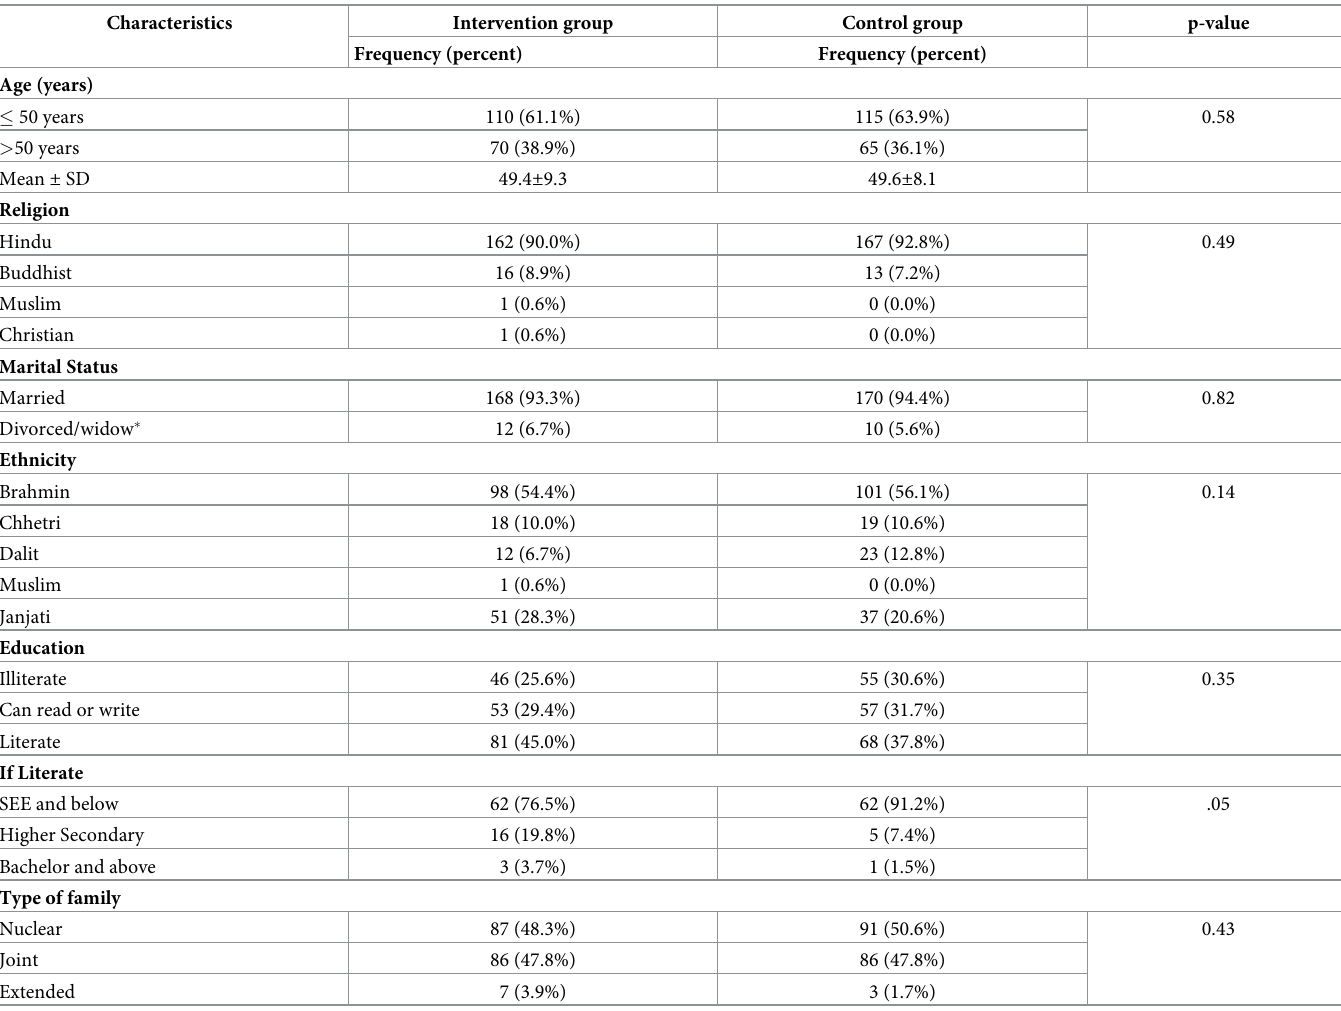
Table 2. Demographic variables of respondents (n =